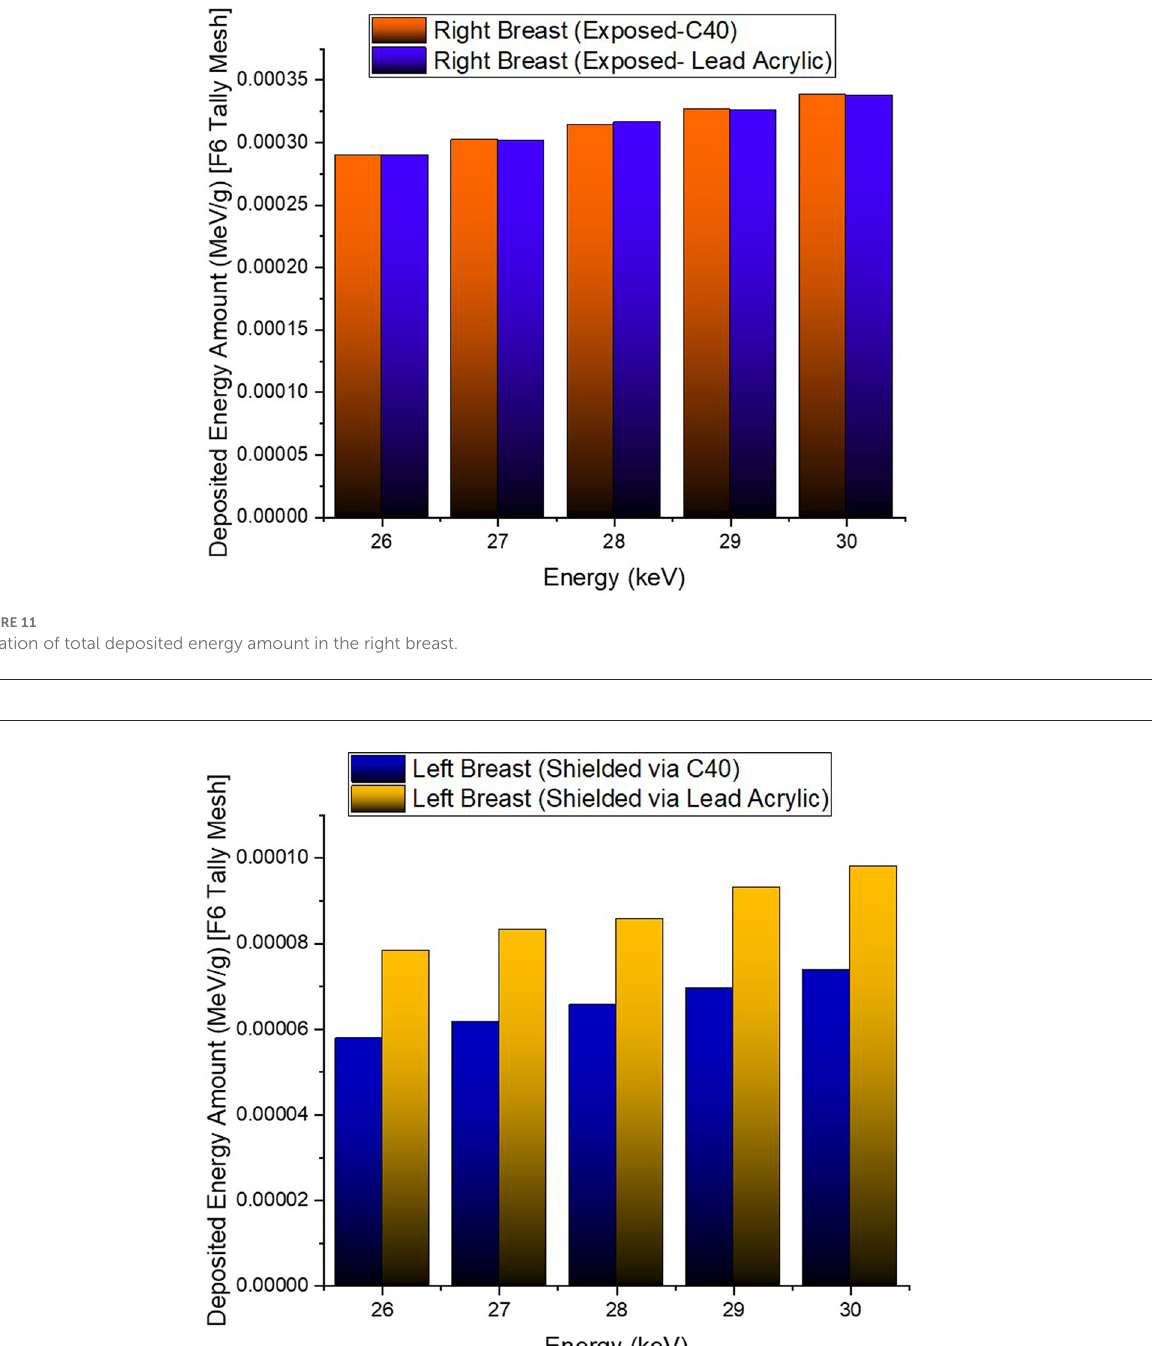
in the three layers for different X-ray energies. Even though the dose values absorbed in different breast layers vary as a function of distance from the source, the total dose absorbed in the left breast for C40 was found to be much less than that for lead-based acrylic. This change is reported to lead to improved protective properties for C40, with a difference of 35–38% for all energy